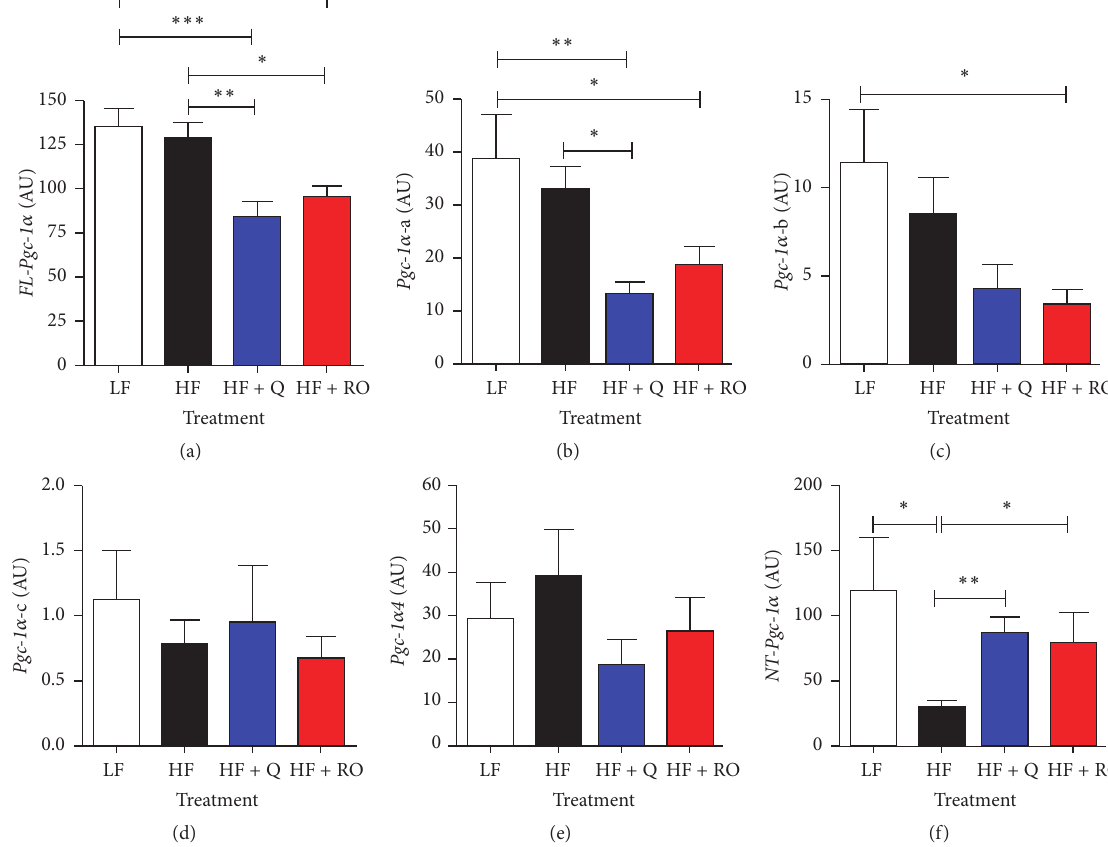
Figure 3: Expressions of (a) FL-Pgc-1 𝛼 , (b) Pgc-1 𝛼 -a , (c) Pgc-1 𝛼 -b , (d) Pgc-1 𝛼 -c , (e) Pgc-1 𝛼 4 , and total NT-Pgc-1 𝛼 isoforms were measured by qRT-PCR in skeletal muscle samples of mice fed a low fat (LF), high fat (HF), high fat plus quercetin (HF + Q), or high fat plus red onion extract (HF + RO) diet for 9wks. Values are shown as means ± SEM in arbitrary units (AU). ∗ denotes significant difference with P < 0.05, ∗∗ P < 0.01, and ∗∗∗ P <